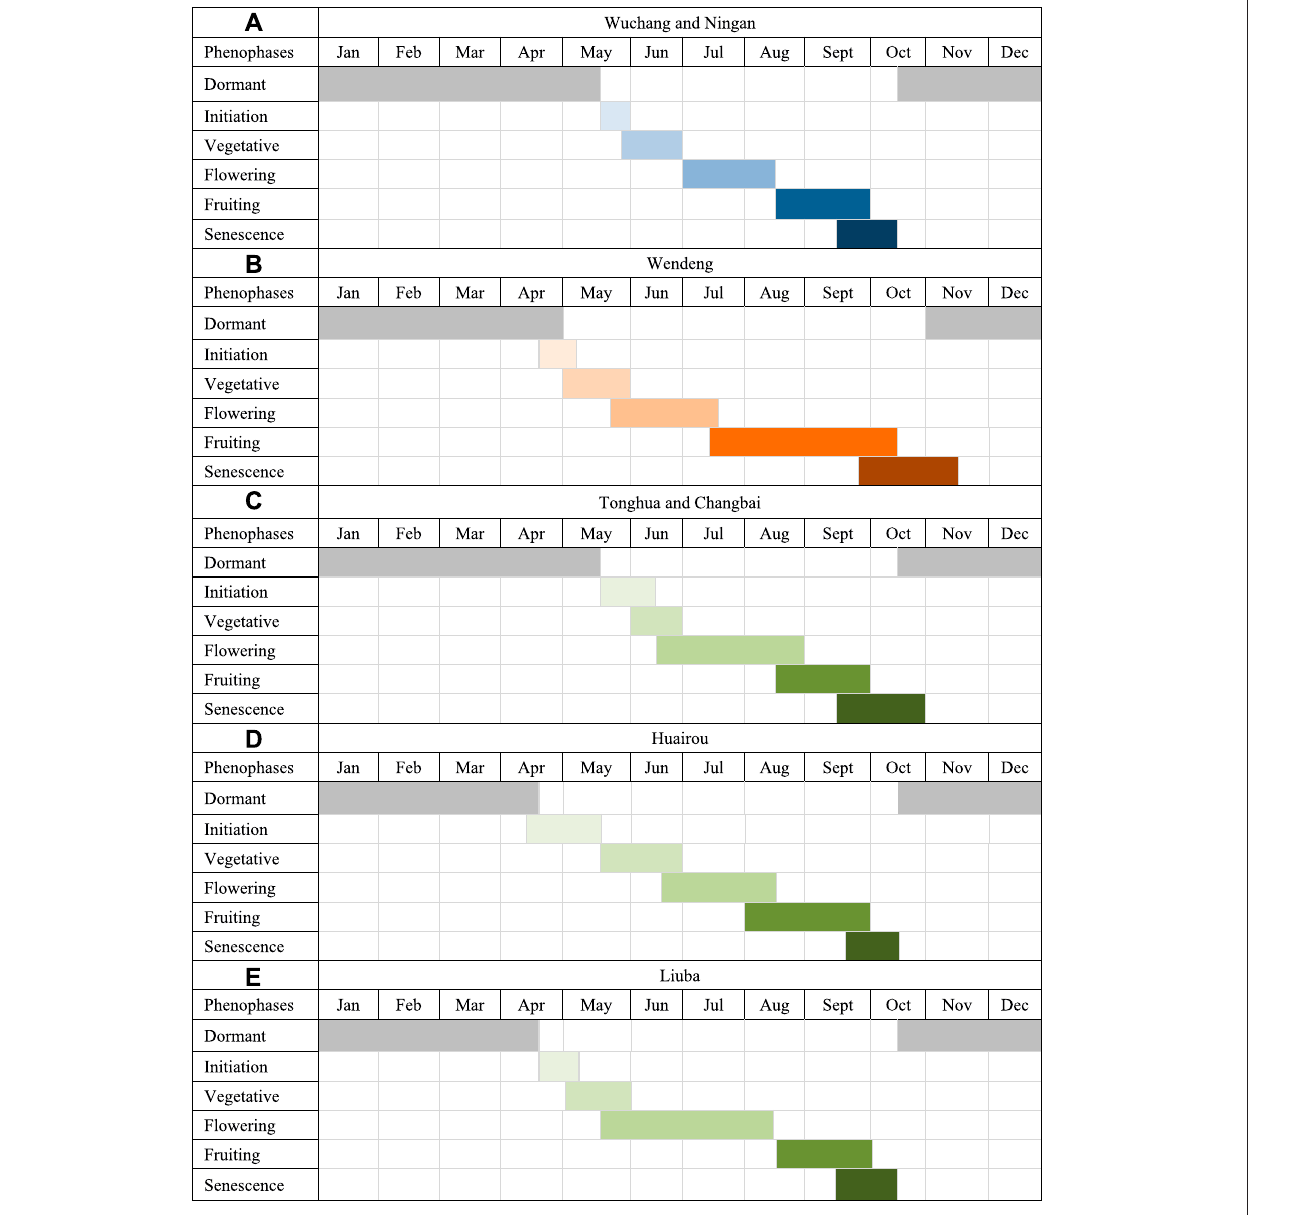
Frontiers in Earth Science |